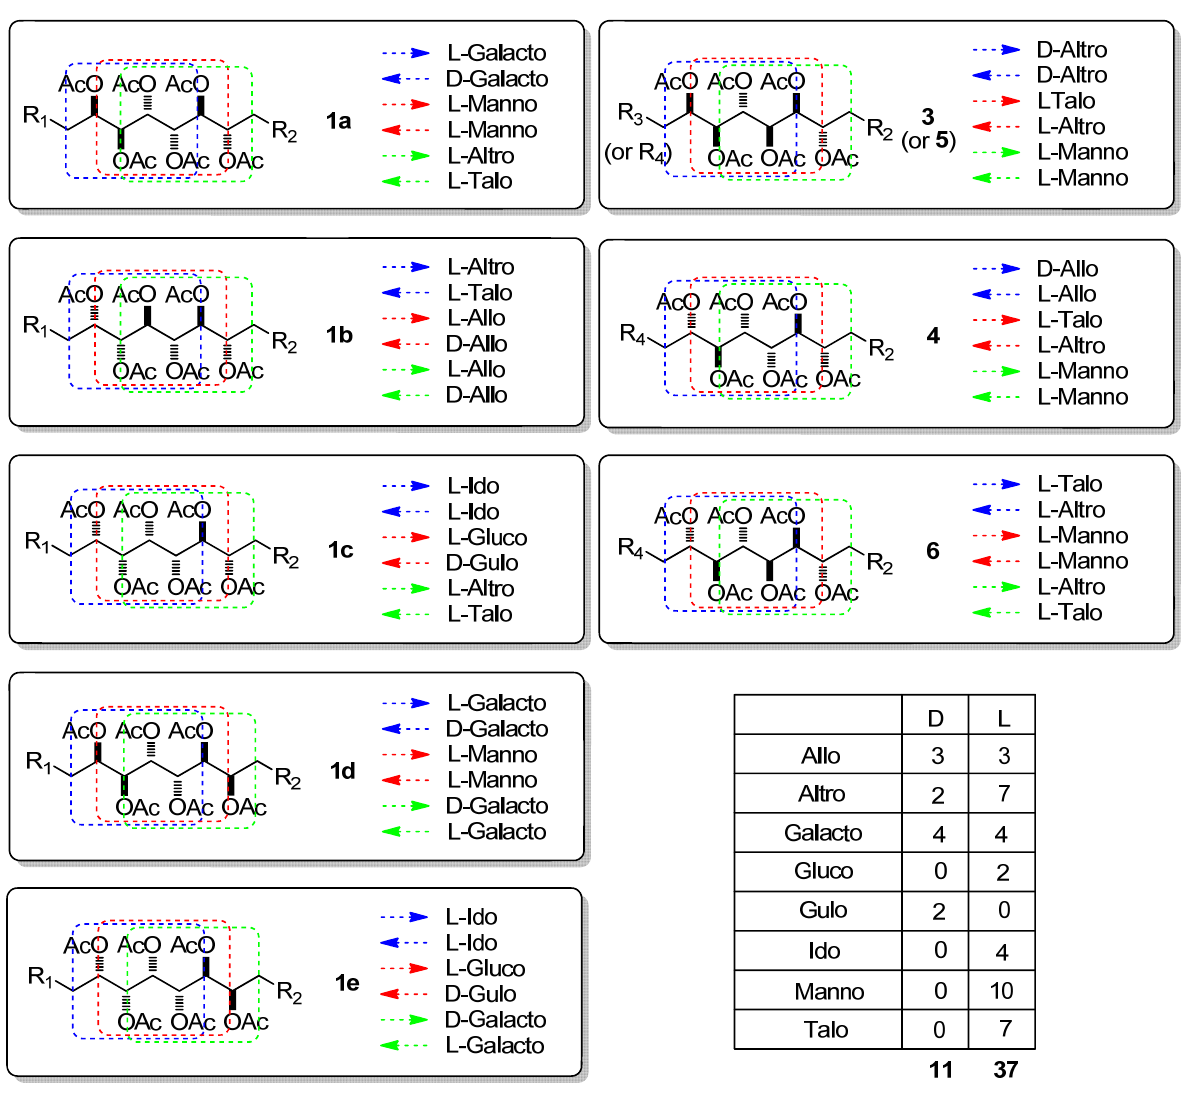
Figure 3. Use of the Quiral program for the study of carbohydrate backbones in the central stereoclusters of Sagittamides A – F